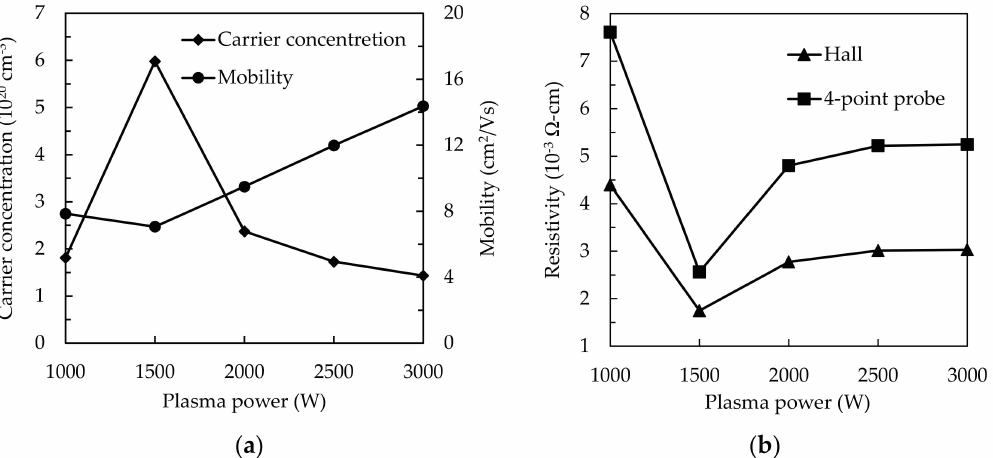
Figure 8. The ( a ) variation of carrier concentration ( Ne ) and mobility ( µ ) and ( b ) the results of resistivity ( ρ ) via respective hall and 4-point probe measurement for the SnO 2 thin films with the increased plasma power from 1000 to 3000